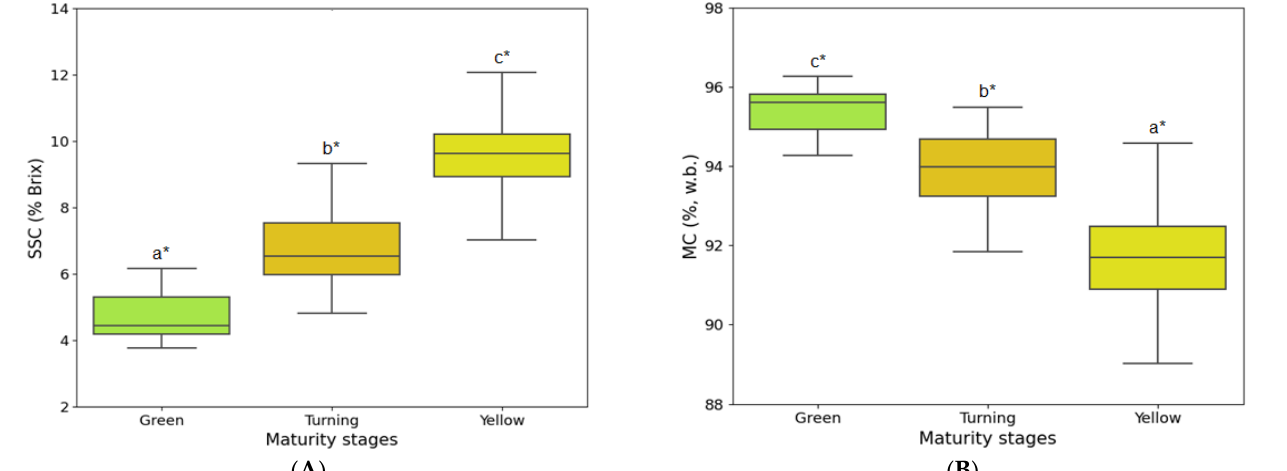
Figure 4. The changes in ( A ) SSC and ( B ) MC according to the maturity stages of oriental melons. Error bars indicate the standard deviation. Means with different letters (a–c) above the bars indicate significant differences based on the Tukey – Kramer multiple range test ( p < 0.05).